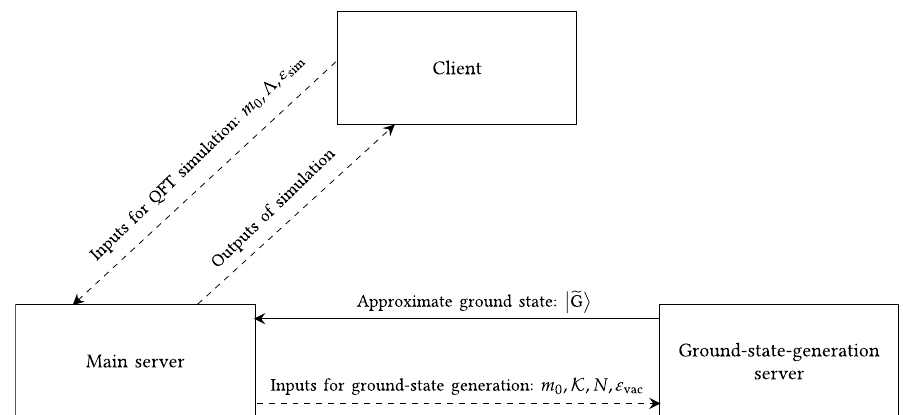
FIG. 4. A client-server frame- work for simulating a QFT. Dashed lines represent classical commu- nication, and solid lines represent quantum communication. The classical inputs to the main and ground-state-generation servers are specified in Tables I and II, respectively, for simulating a mas- sive scalar bosonic QFT. Output from the ground-state-generation server is an approximation for the free-field ground state.